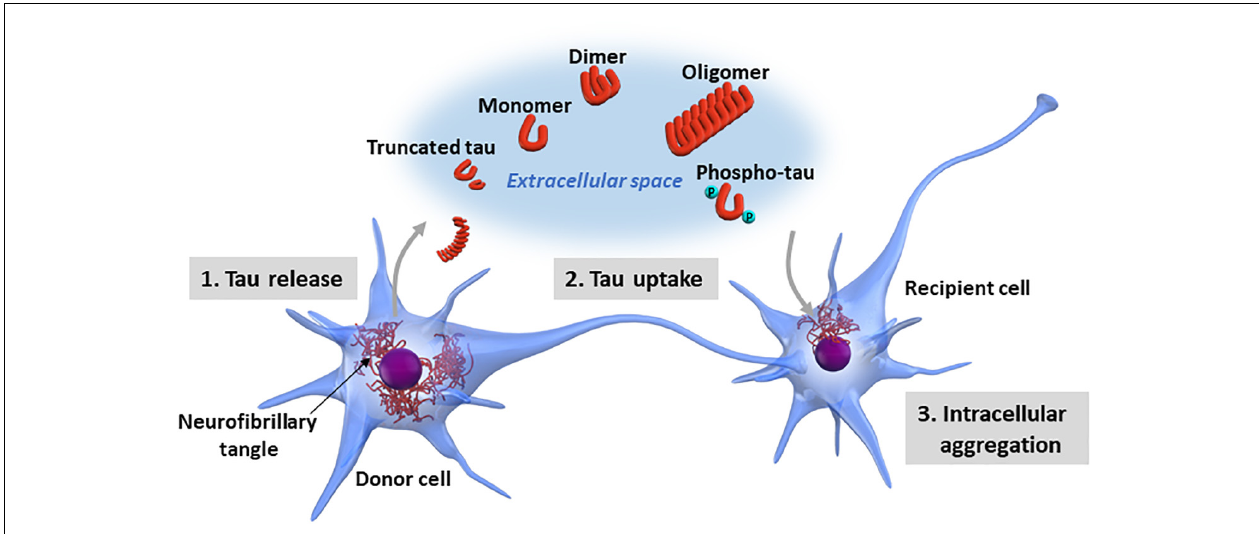
FIGURE 2 | Neuron-to-neuron transfer of tau. The processes involved in tau propagation can be divided into three basic steps: (1) the pathological form of tau is released into the extracellular space from the donor cell; (2) the pathological tau released into the extracellular space is taken up by recipient cells; and (3) the pathological tau taken up into the recipient cells forms new intracellular aggregates. Tau exists in various forms in terms of biochemical property, including monomeric, oligomeric, truncated, and phosphorylated forms. Additionally, tau may undergo a wide range of posttranslational modifications, including acetylation, glycation, isomerization, nitration, SUMOylation, and ubiquitination or a mixture of these modifications. It is still largely unknown which forms of tau are released into the extracellular space and involved in tau propagation.